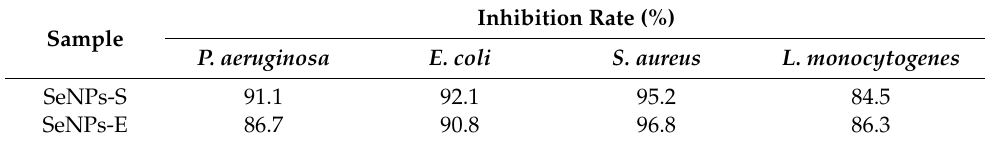
Figure 7. Colony − forming units (CFU) assay using four pathogens after treatment with SeNPs − S and SeNPs − E with varying concentrations from 20 μ g/mL to 200 μ g/mL. ( a , b ) Agar plate images of CFU test of P. aeruginosa. The original (bacteria + SeNPs) solution is 10 0 , while 10 − 1 , 10 − 2 , 10 − 3 and 10 − 4 mean diluting the original solution 10, 100, 1000 and 10,000 times, respectively, to make the colonies more countable. Viable cell concentration of P. aeruginosa ( c ), E. coli ( d ), S. aureus ( e ) and L. monocyto- genes ( f ) after 24 h exposure to different concentrations of SeNPs-S and SeNPs-E. Table 2. Inhibition rate of SeNPs-S and SeNPs-E to four pathogens at 200 μ g/mL.